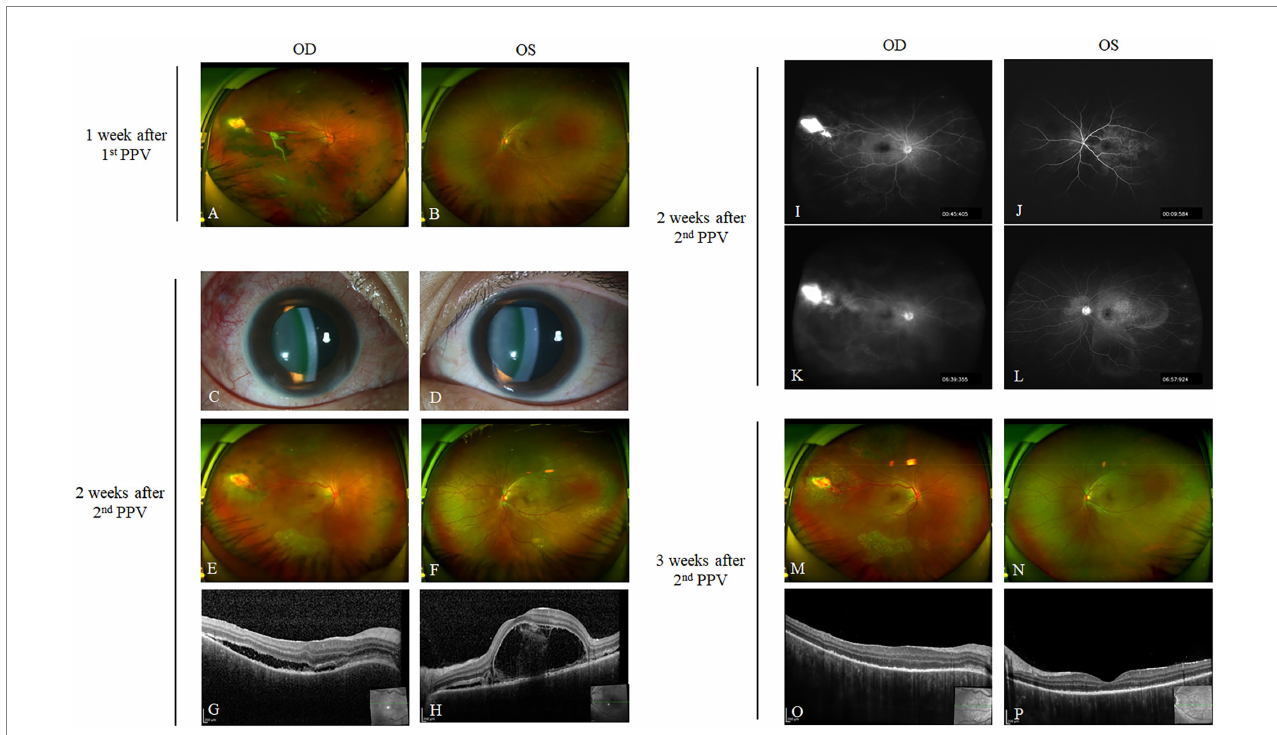
FIGURE 1 Typical manifestations and resolution of SO. One week after the first PPV, residual vitreous hemorrhage and a yellowish supertemporal lesion were found in the right eye on the initial arrival at our hospital (A) , although the ocular fundus was apparently normal in the left eye (B) . Two weeks after the second PPV,